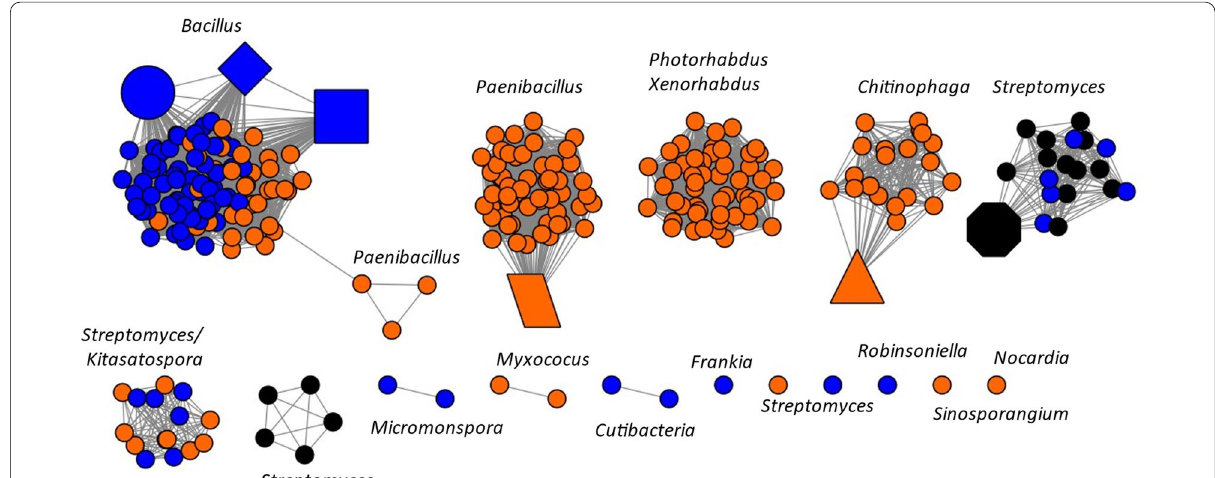
Fig. 5 A Aminopolyol dehydrogenase SSN with an alignment score threshold of 50% with only 3GC containing nodes. Color coding based on type of phosphatase found within 3GC. Clusters are labeled based on what genera is 75% or more of cluster, if this condition was not met, the top two genera are listed. Polygons identify species as defined for Fig. 3